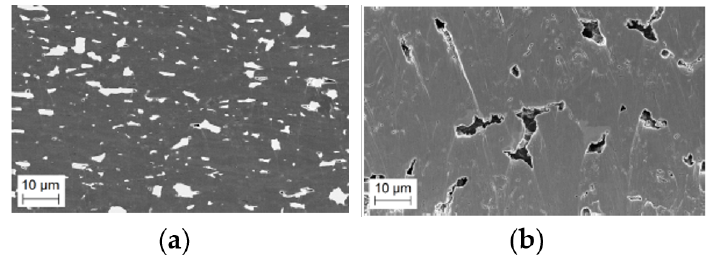
Figure 30. SEM observations of ion-polished MoGr ( a ) and graphite ( b ) substrates. MoGr has its through- plane direction perpendicular to the image. Large µ m-scale voids are visible on graphite (holes in black), while Mo-carbide inclusions are visible on MoGr (white spots).